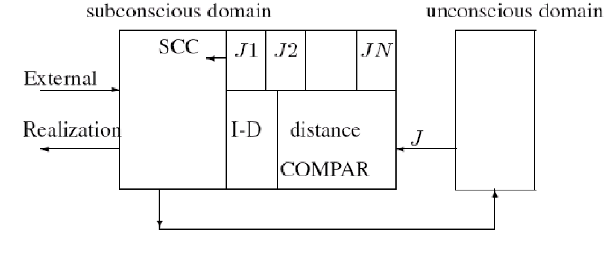
Figure 2. Model2ofsubconscious/unconsciousfunctioning(comparativeanal- ysis of